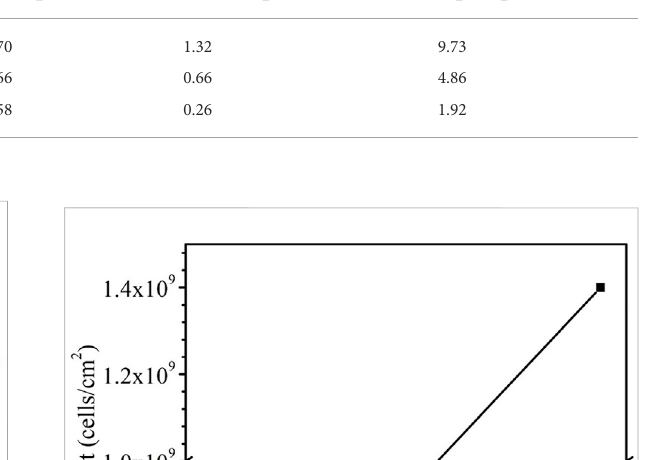
TABLE4Dataobtainedandcalculatedfordogbonecouponswithdifferentheadspacevolumes( fi xed150 mlbrothvolume)after14-dayincubatedin anaerobic bottles. Headspace volume (mL)